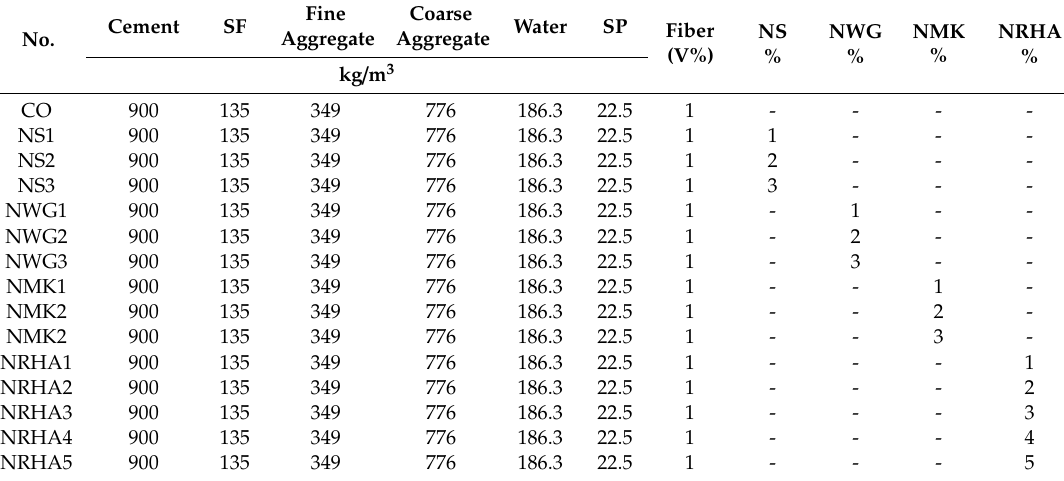
Table 4. Mixture proportions of